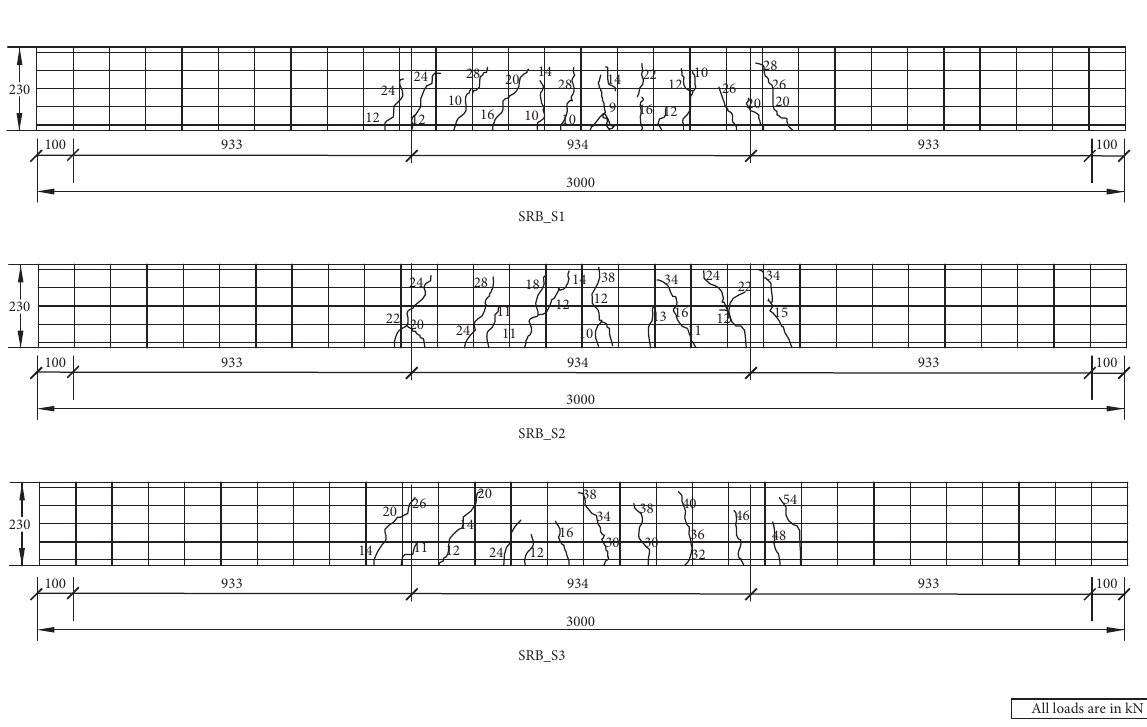
Figure 7: The crack pattern of GPCSC for singly reinforced beam (SRB).